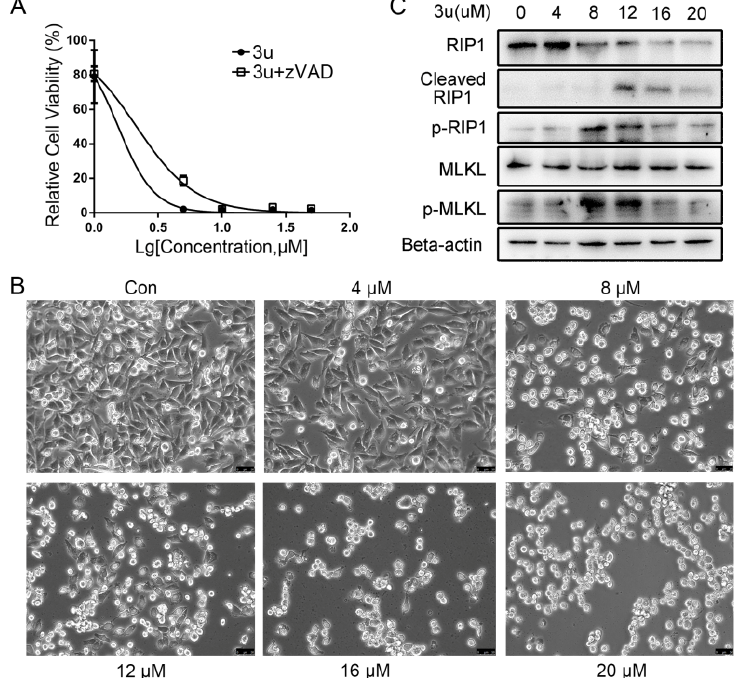
Figure 6. The mechanism of cell death induced by low concentrations of 3u was not apoptosis but rather necroptosis. In A375 cells ( A ) the cell viabilities in response to 3u did not differ greatly with or without pretreatment of 30 µM zVAD-fmk for 1 h. A375 cells were treated with various concentrations of 3u for 6 h, and then ( B ) cell morphological changes were observed under microscope (200X). Scale bar 50 µm; and ( C ) necroptosis-related proteins were examined via